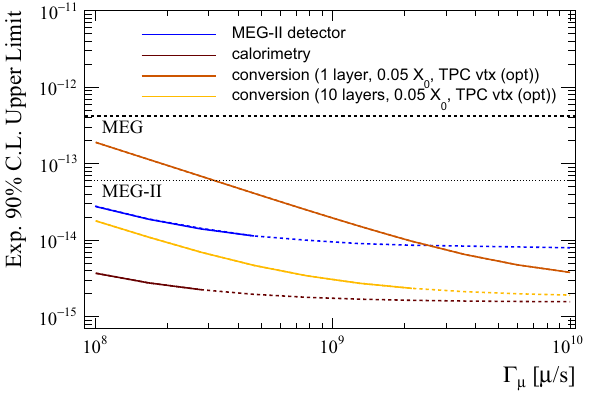
Fig. 8 Expected 90% C.L. upper limit on the Branching Ratio of μ + → e + γ indifferentscenariosfora3-yearrun.Calorimeteryandthe photon conversion technique are compared. The lines turn from contin- uous to dashed when the number of background events exceeds 10. The horizontal dashed and dotted lines show the current MEG limit and the expected MEG-II